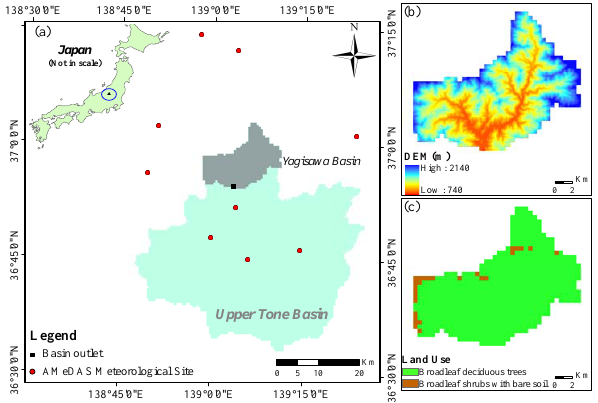
Fig. 2. (a) Study area in Upper Tone River basin; (b) digital